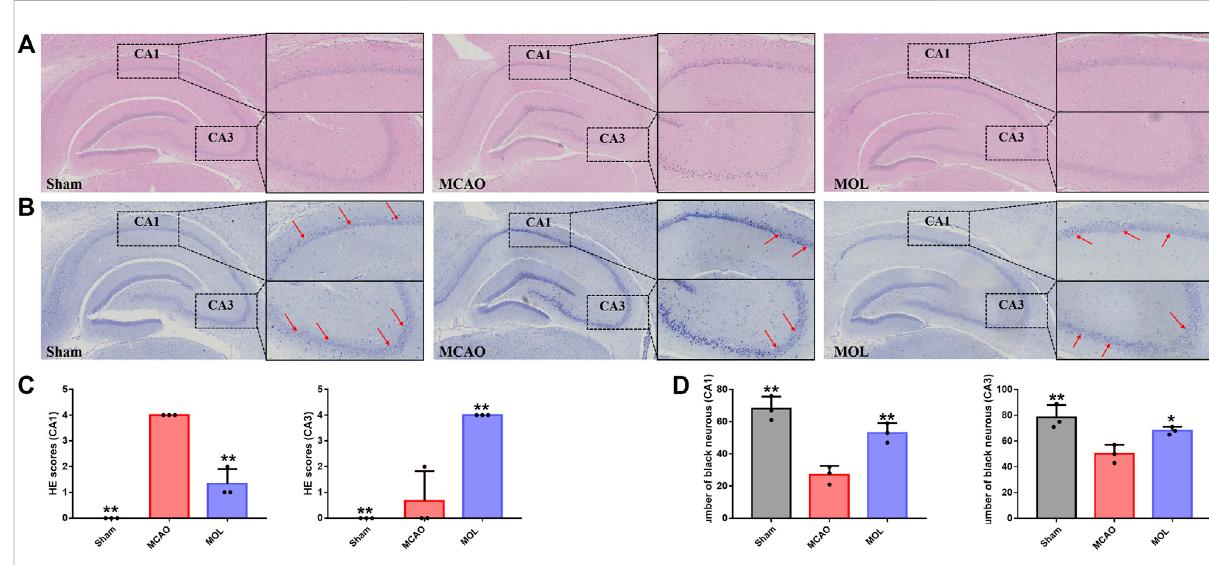
FIGURE 2 MOL can improve hippocampal neuronal cell damage in MCAO rats. (A) HE staining of rat hippocampus; (B) Nissl staining of rat hippocampus; (C) Pathological scores of HE staining in hippocampal CA1 and CA3 regions; (D) Pathological score of Nissl staining in the CA1, CA3 region of the hippocampus. Data expressed as Mean ± SD, ** p < 0.01, * p < 0.05 vs. MCAO